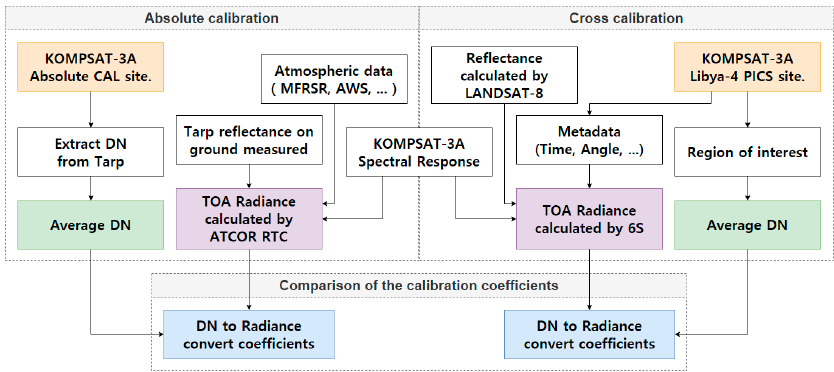
Figure 1. A flow chart of the three main steps of this study. Table 1. Image list and metadata used.